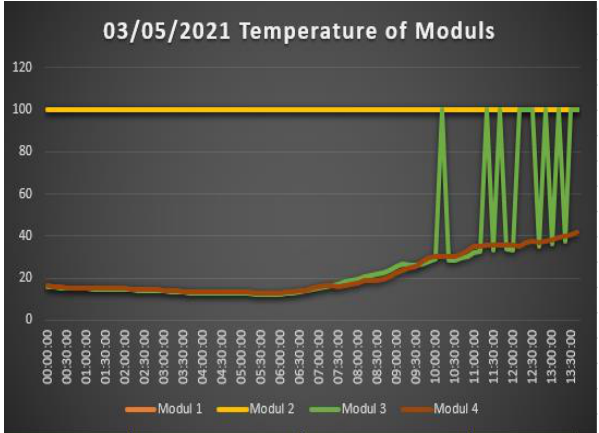
Figure 2.8 . Measured values of four modules at four different